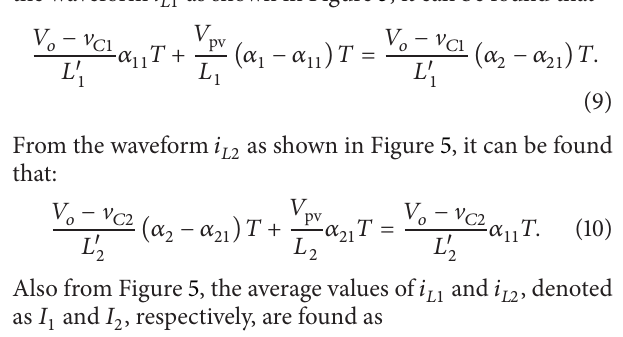
Figure 6: The control flow chart of DSME PWM